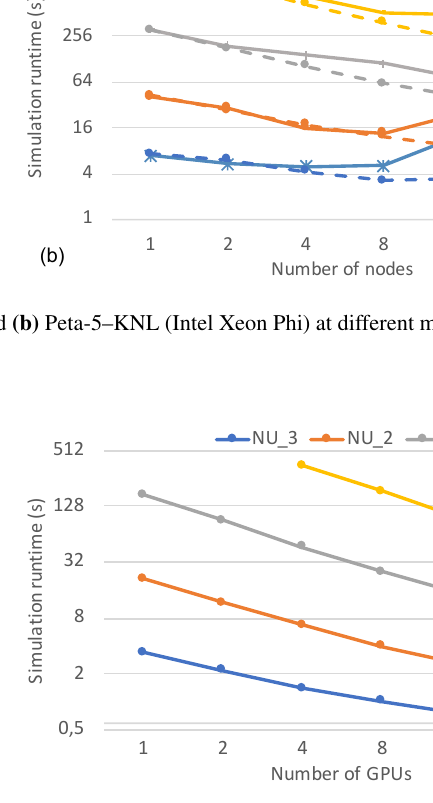
Figure 10. Performance scaling on Wilkes2 (P100 GPU) at different mesh